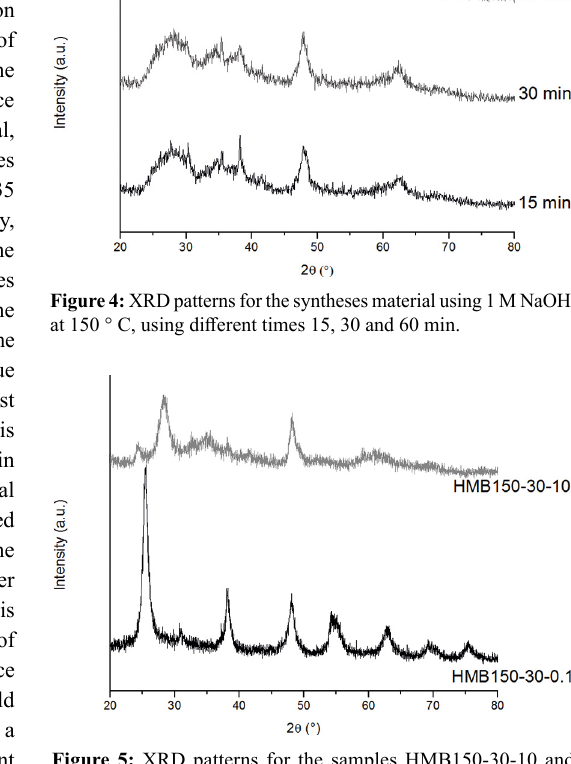
Figure 5: XRD patterns for the samples HMB150-30-10 and